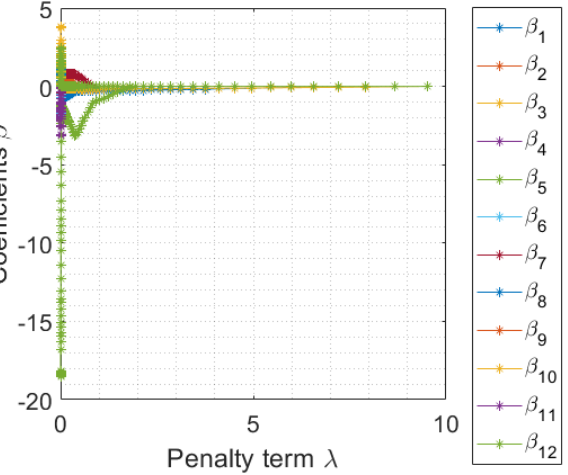
Figure 7. An example of the coefficients ˆ β given the different penalty term λ values.